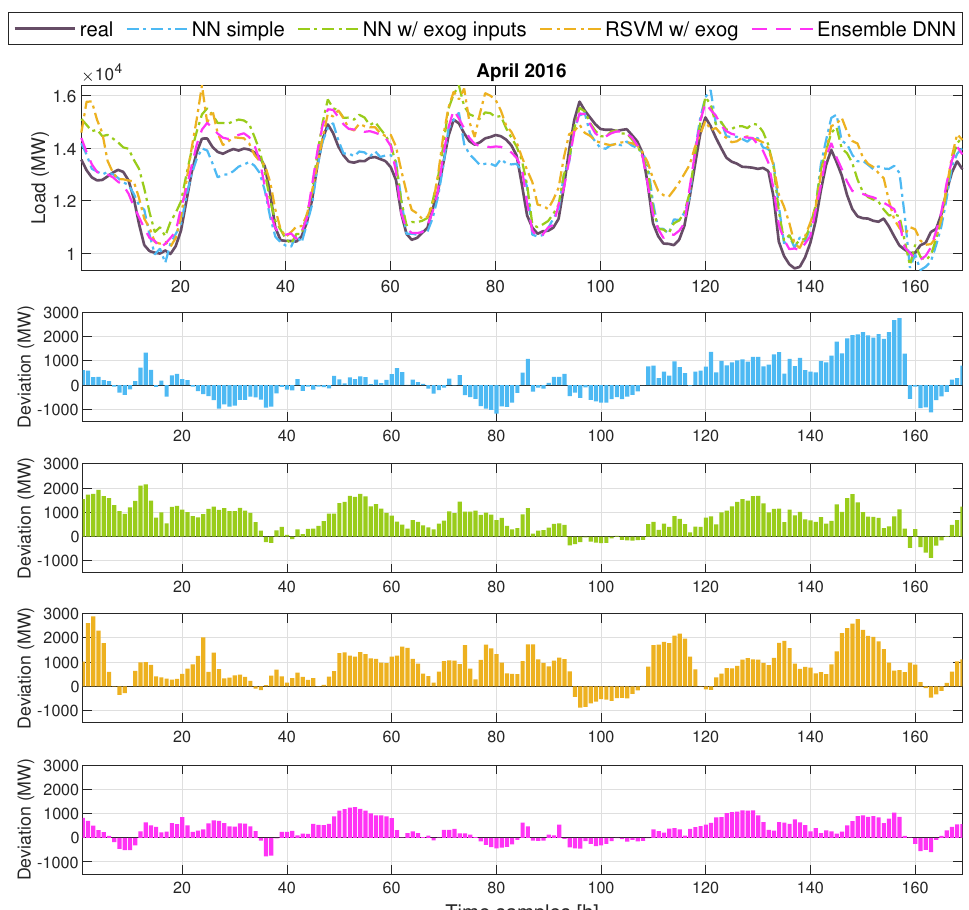
Figure 7. Predicted loads vs. real load and the respective mean deviation (signed error) of each method: 1st week of April